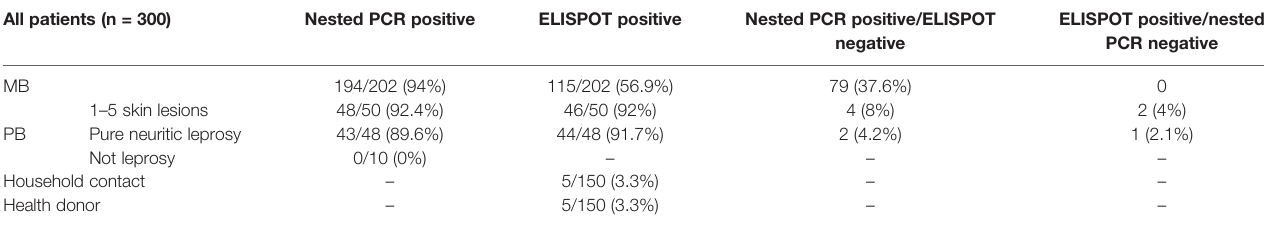
TABLE 3 | Diagnostic performance of nested PCR and ELISPOT assay of 300 leprosy cases by diagnostic category. All patients (n =